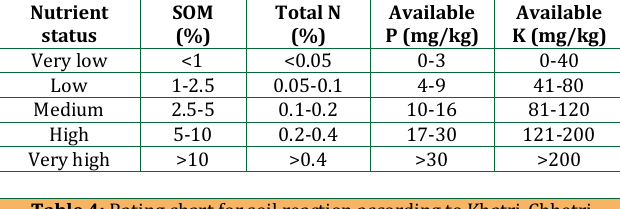
Table 4: Rating chart for soil reaction according to Khatri-Chhetri Soil pH value